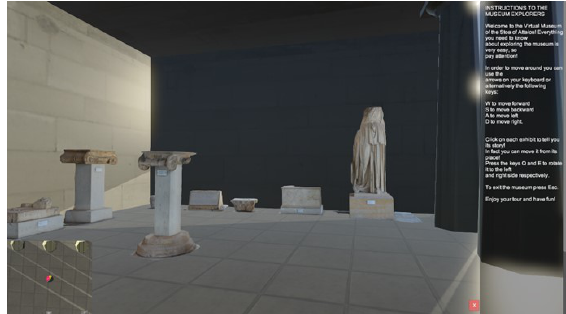
Figure 9: At the beginning of the virtual tour the visitor reads the available